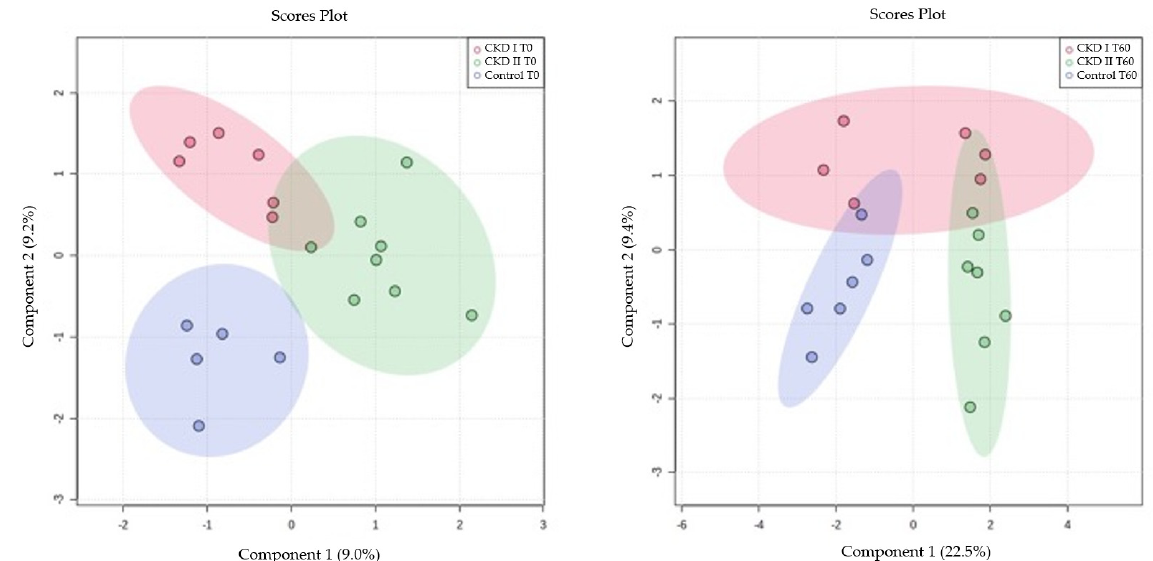
Figure 2. Partial Least Squares (PLS) for serum metabolomics data at baseline (T0) and after sixty